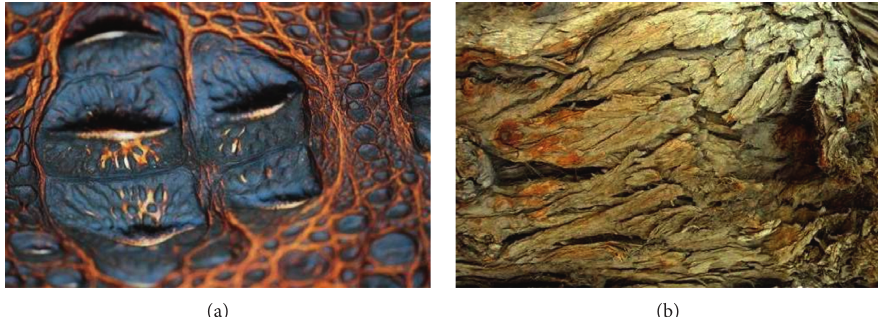
Figure 1: Local magnification of the body surfaces: (a) lizard; (b) diversiform-leaved